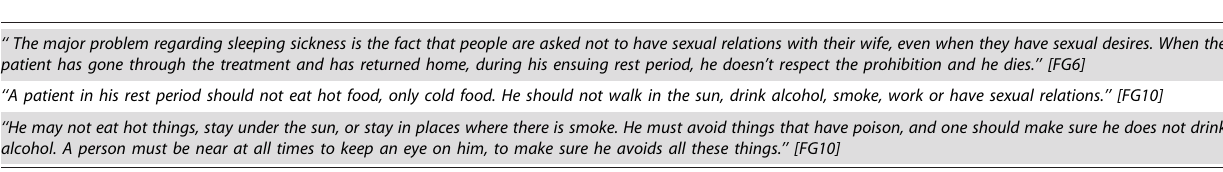
Table 3. Citations illustrating the prohibitions linked to the resting period after treatment.